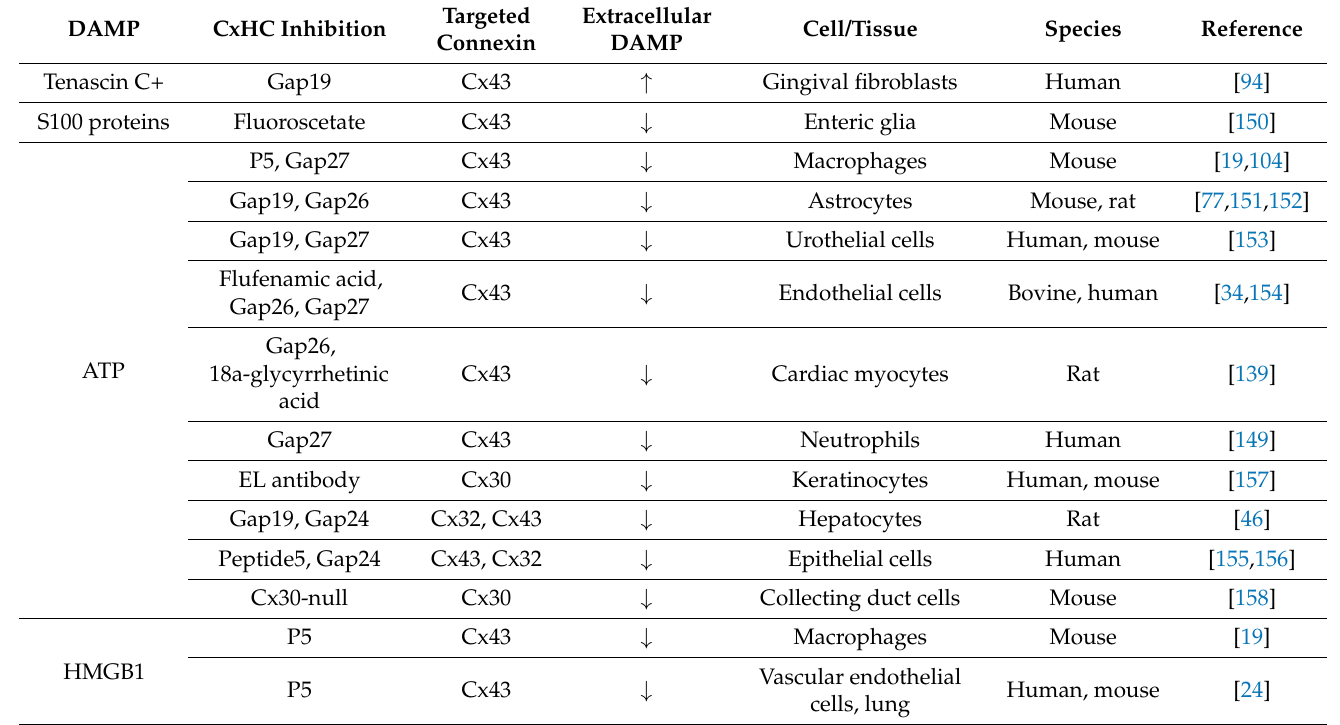
Table 3. Effects of connexin hemichannel blockers on DAMP